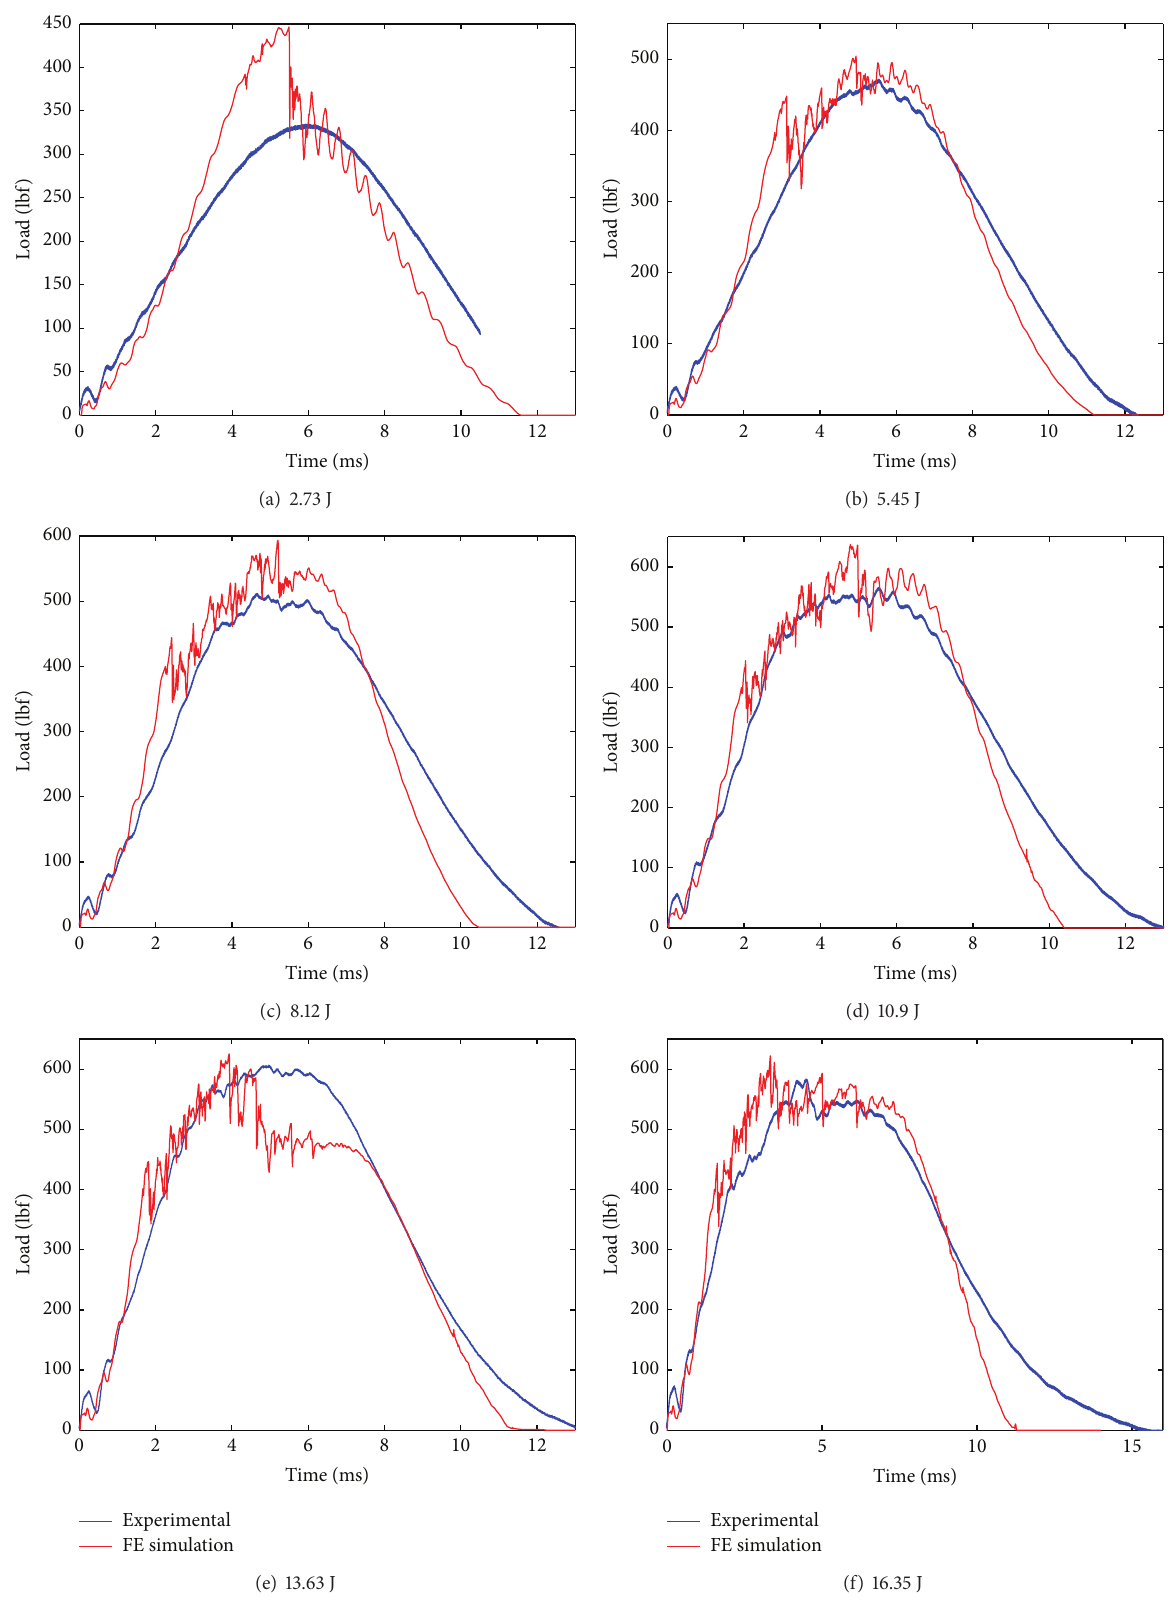
Figure 9: Impact load versus time plots for AS4 Carbon/Epoxy laminates at six impact energy